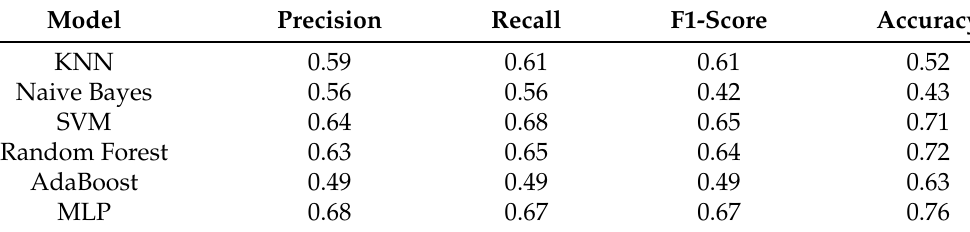
Table 8. Classification Results Embeddings